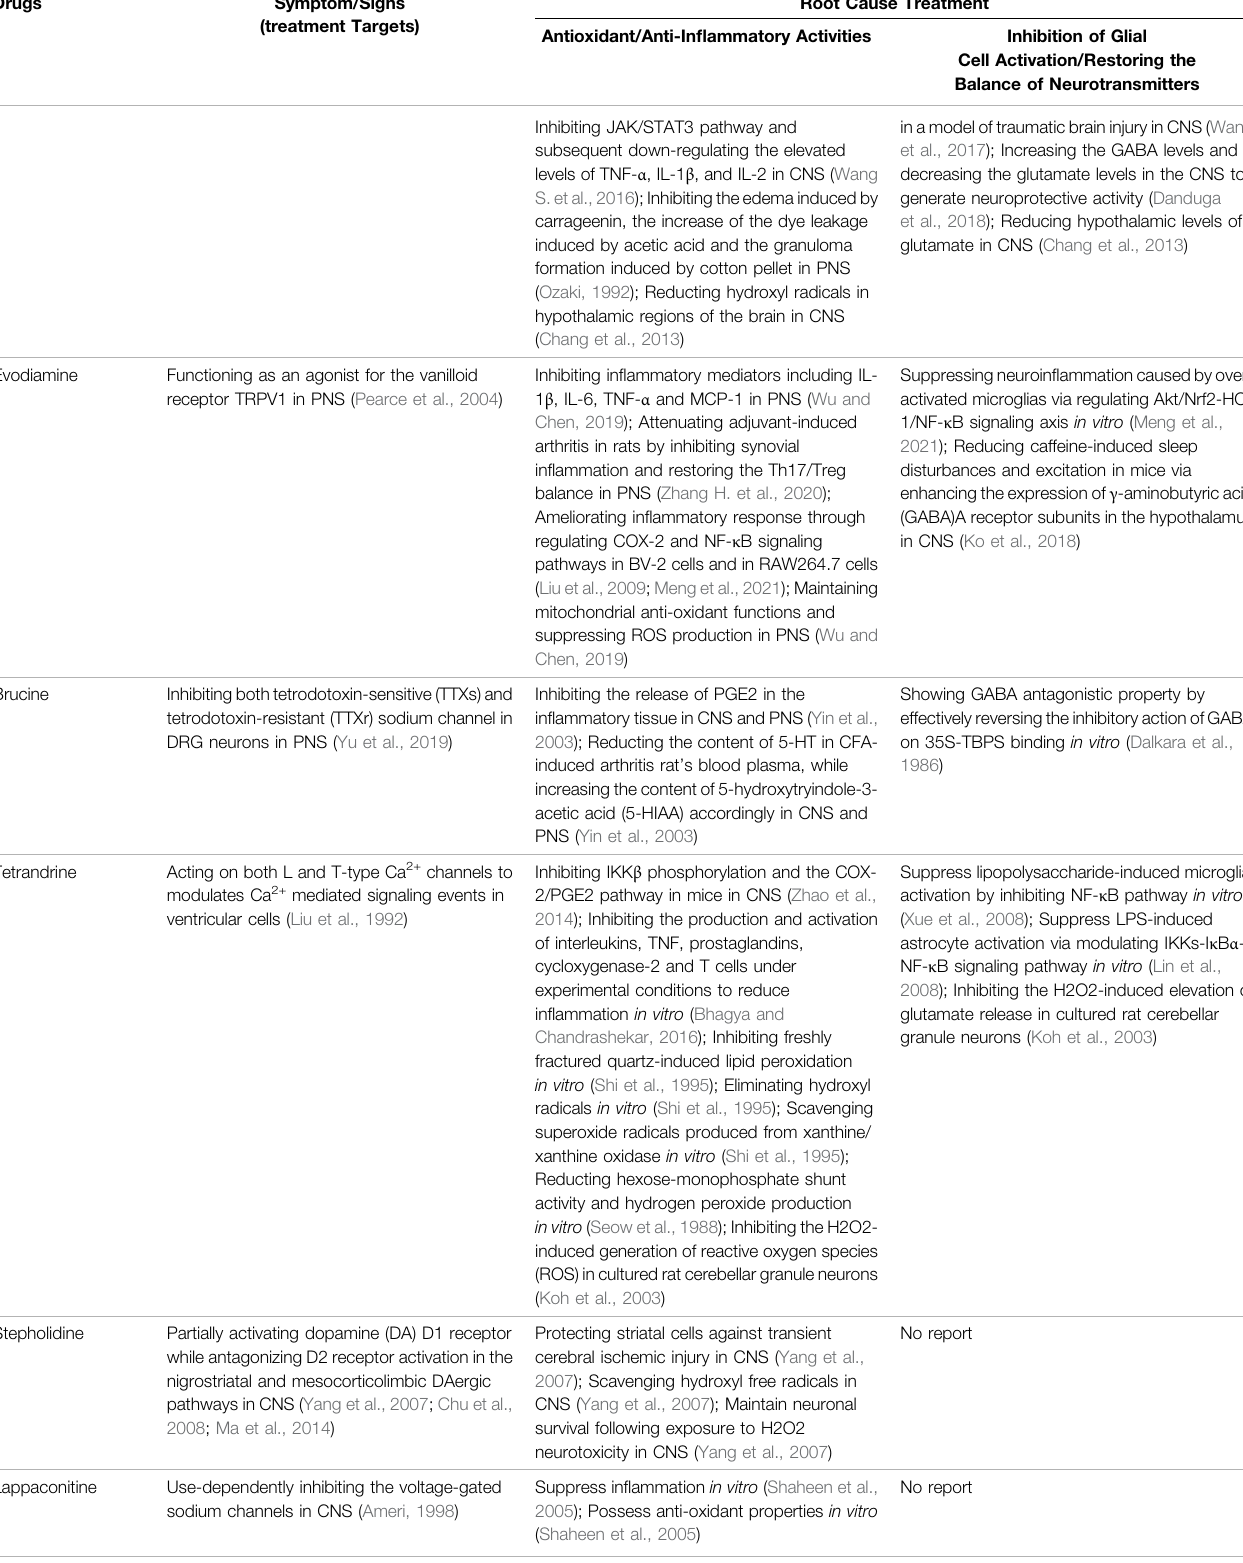
TABLE 2 | ( Continued ) Mechanism similarity between TCM derived analgesic